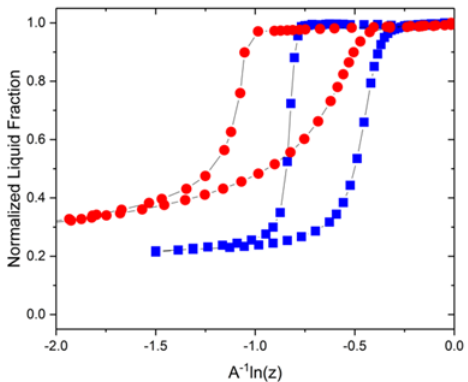
Figure 2. Comparison of nitrogen sorption isotherms (red circles) and NMR cryoporometry transi- tions (blue squares) of water in VYCOR porous